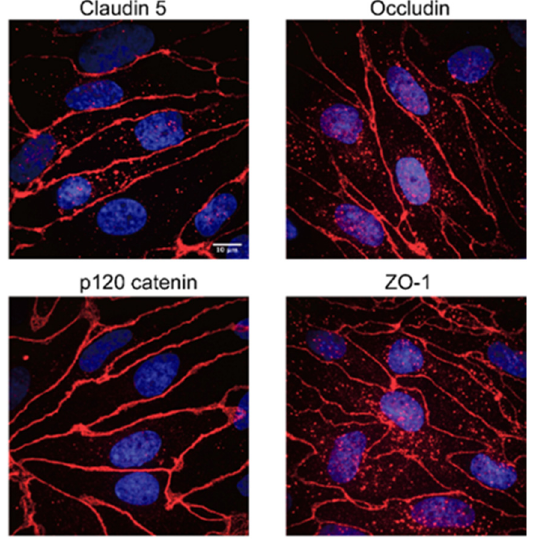
Figure 3. Immunocytochemical analysis of porcine brain endothelial cells (PBECs). Immunofluorescence microscopy analysis of tight junction components Claudin 5, Occludin, ZO-1 and adherens junction protein p120 catenin of PBECs grown on permeable membrane filter inserts with a growth area of 1.12 cm 2 in the presence of rat astrocyte conditioned medium in the basolateral compartment. Scale bar for all pictures: 10 μ m.